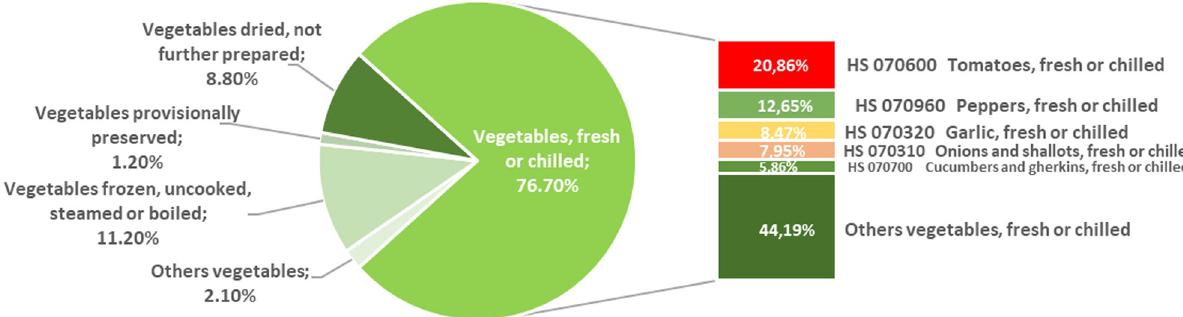
Fig 2. World trade of fresh vegetables sector and other vegetable products